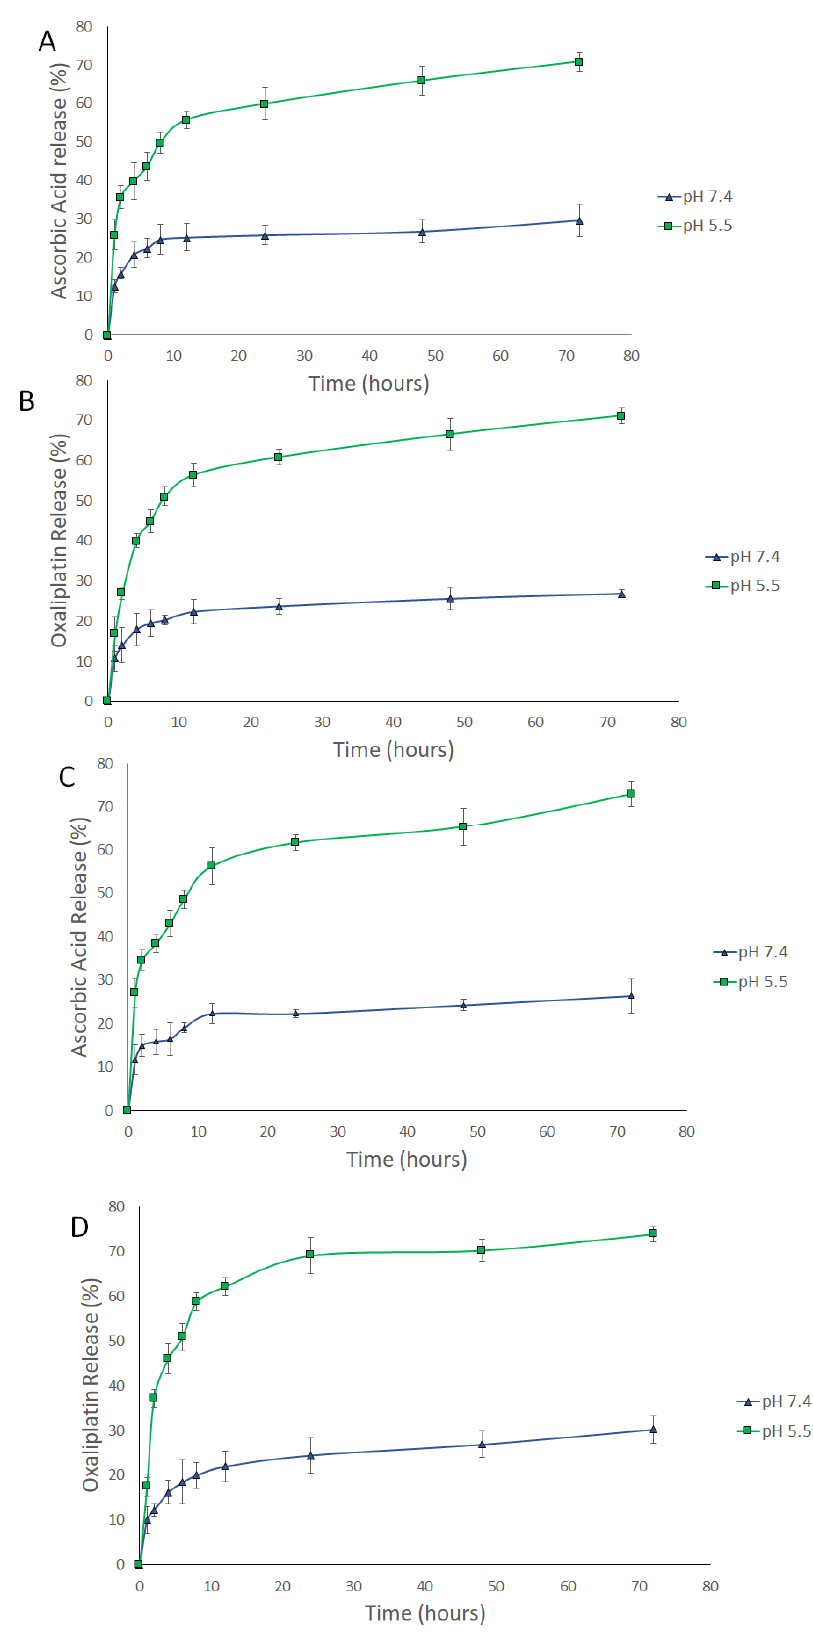
Figure 3. Time-dependent release profiles of ( A ) AA from AA/CS NPs, ( B ) OX from OX/CS NPs, ( C ) AA from AA-OX/CS NPs and ( D ) OX from AA-OX/CS NPs at 37 °C, at pH 7.4 and 5.5.